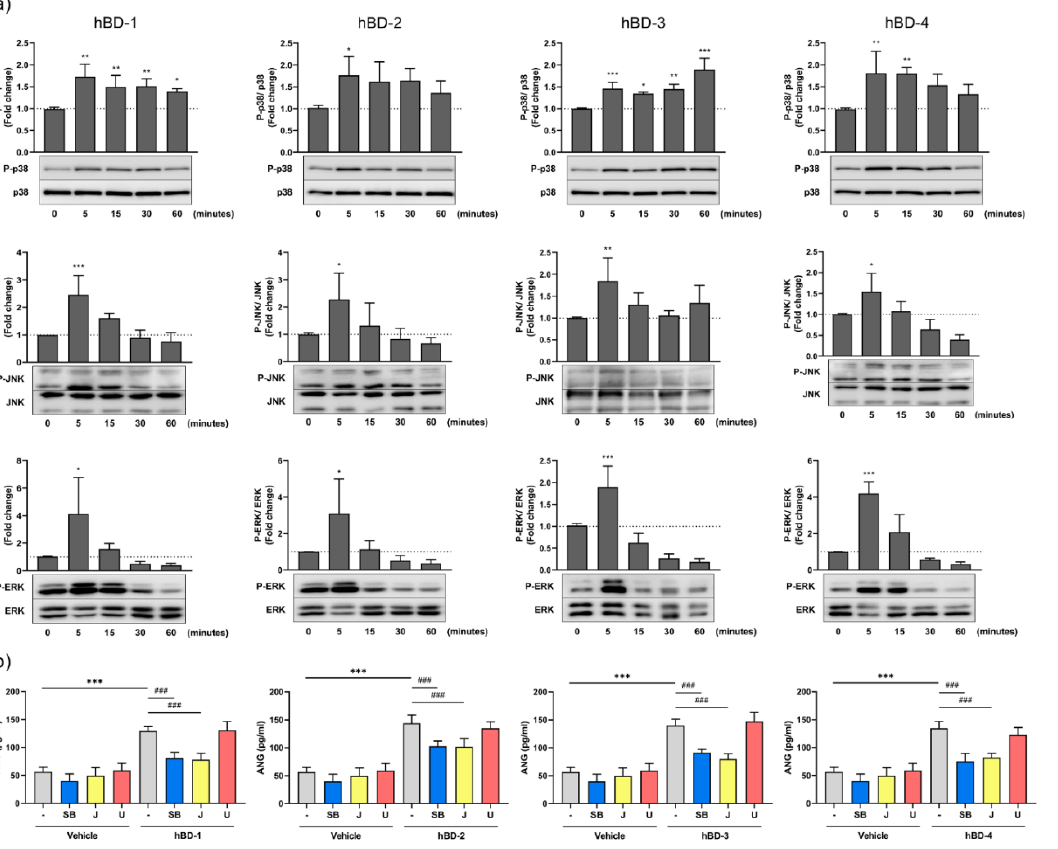
Figure 5. hBDs induce ANG production by activating the p38 and JNK signaling. ( a ) Human dermal fibroblasts were stimulated with 20 μ g/mL hBD-1, 20 μ g/mL hBD-2, 10 μ g/mL hBD-3, or 20 μ g/mL hBD-4 for 5–60 min, and the levels of phosphorylated and unphosphorylated MAPKs (p38, JNK and ERK1/2) in whole cell lysates were analyzed by Western blotting. * p < 0.05, ** p < 0.01 and *** p < 0.001 compared between the unstimulated (0 min) and the hBD-stimulated groups by one-way ANOVA with Tukey’s multiple comparisons test. ( b ) Fibroblasts were preincubated with 10 μ M SB203580 (SB, p38 inhibitor), 10 μ M JNK inhibitor II (J), 10 μ M U0126 (U, ERK inhibitor), or solvent (-) for 2 h. Cells were then stimulated for 6 h with 20 μ g/mL hBD-1, 20 μ g/mL hBD-2, 10 μ g/mL hBD- 3, or 20 μ g/mL hBD-4. The concentrations of ANG in cell-free supernatants were determined by ELISA. *** p < 0.001 compared between the presence and absence of hBDs without inhibitor; ### p < 0.001 compared between the inhibitor-treated and untreated group with hBD stimulation by one- way ANOVA with Tukey’s multiple comparisons test. All results are the means ± SDs of 3–6 inde- pendent experiments. In addition, we focused on the NF- κ B pathway, because this pathway has been im- plicated in antimicrobial peptide-mediated cell activation [26,27], and hBDs have been demonstrated to activate the NF- κ B signaling pathway in human epidermal keratinocytes and cervical cancer cells [28,29]. To determine whether hBDs activated NF- κ B signaling in fibroblasts and thereby promoted the nuclear translocation of NF- κ B, NF- κ B expression in the nucleus was analyzed after hBD stimulation of fibroblasts. hBD-1, hBD-2, hBD-3, and hBD-4 significantly increased the levels of NF- κ B in the nucleus at 60 min poststimu- lation (Figure 6a). The observation that hBD-mediated ANG secretion was suppressed by pretreatment with NF- κ B activation inhibitor II suggests that the NF- κ B signaling path- way is necessary for hBD-mediated ANG secretion (Figure 6b). We confirmed that the nuclear translocation of NF- κ B was suppressed in fibroblasts following treatment of cells with NF- κ B activation inhibitor II (Supplementary Figure S5). Collectively, these data demonstrated that the MAPK JNK and p38 and NF- κ B signaling pathways are necessary for the hBD-mediated production of ANG by fibroblasts.